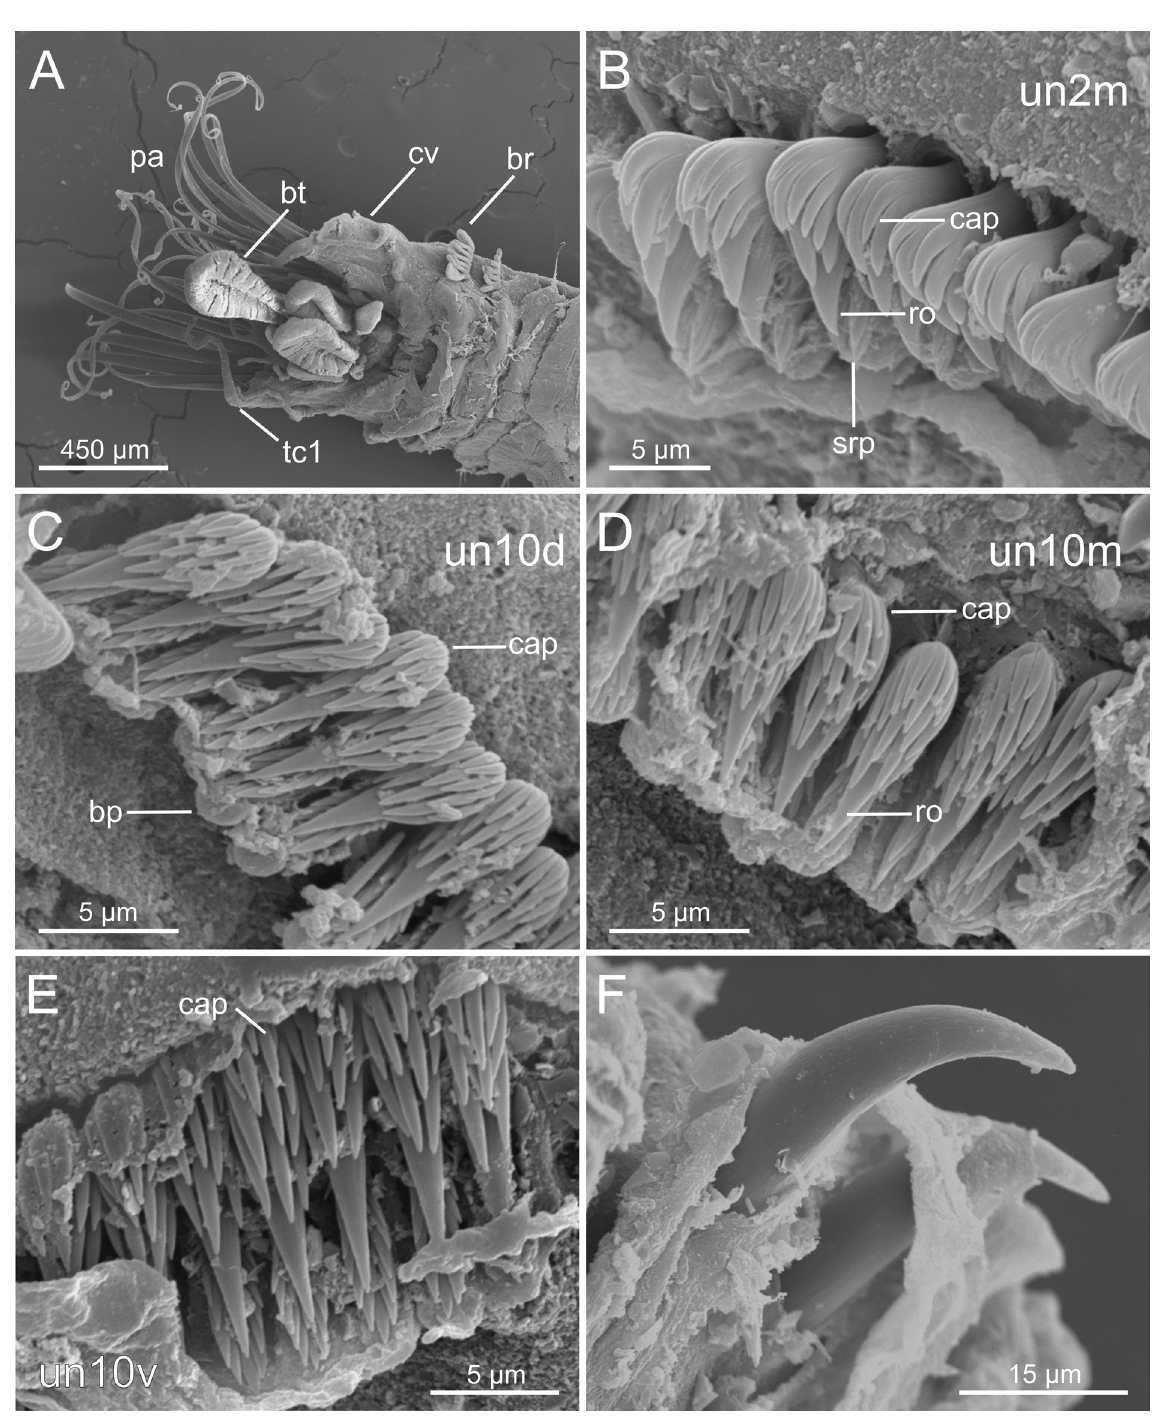
Fig. 13. Cistenides hyperborea Malmgren, 1866. SEM micrographs from a small specimen (BIOICE sample 2041, IINH-40470). A . Anterior end, ventral view. B . Unciniger 2, median uncini. C–E . Unciniger 10, dorsal, median and ventral uncini, respectively. F . Scaphal